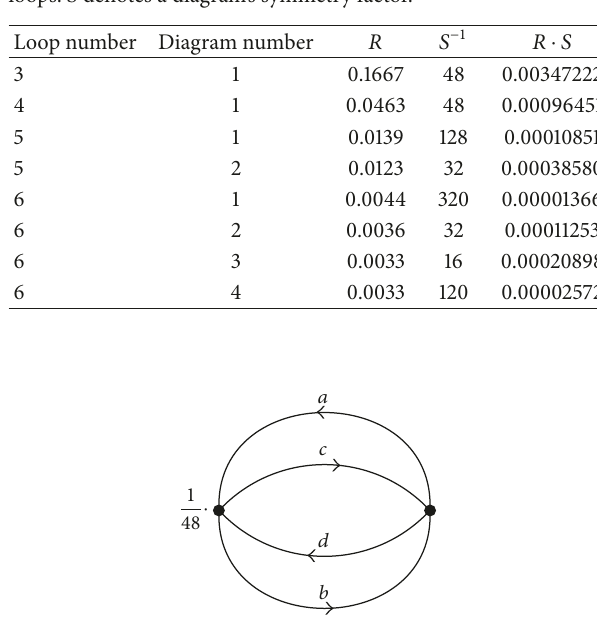
Table 1: Ratio 𝑅 of allowed versus a priori possible energy-sign and scattering-channel combinations for 2PI bubble diagrams up to six loops. 𝑆 denotes a diagram’s symmetry factor.